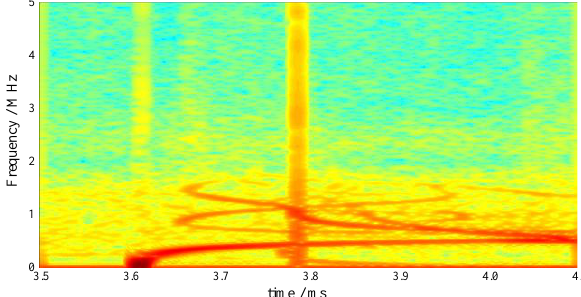
Figure 11. The first order mode included in the time-frequency joint spectrum of bar 01.